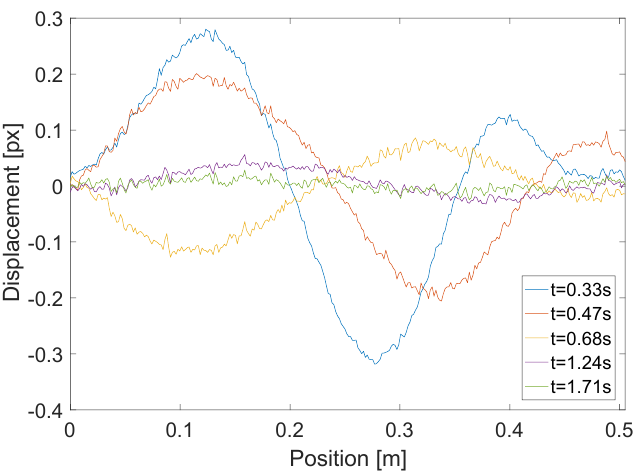
Figure 6. Example of deflections obtained for the clamped–clamped beam at different